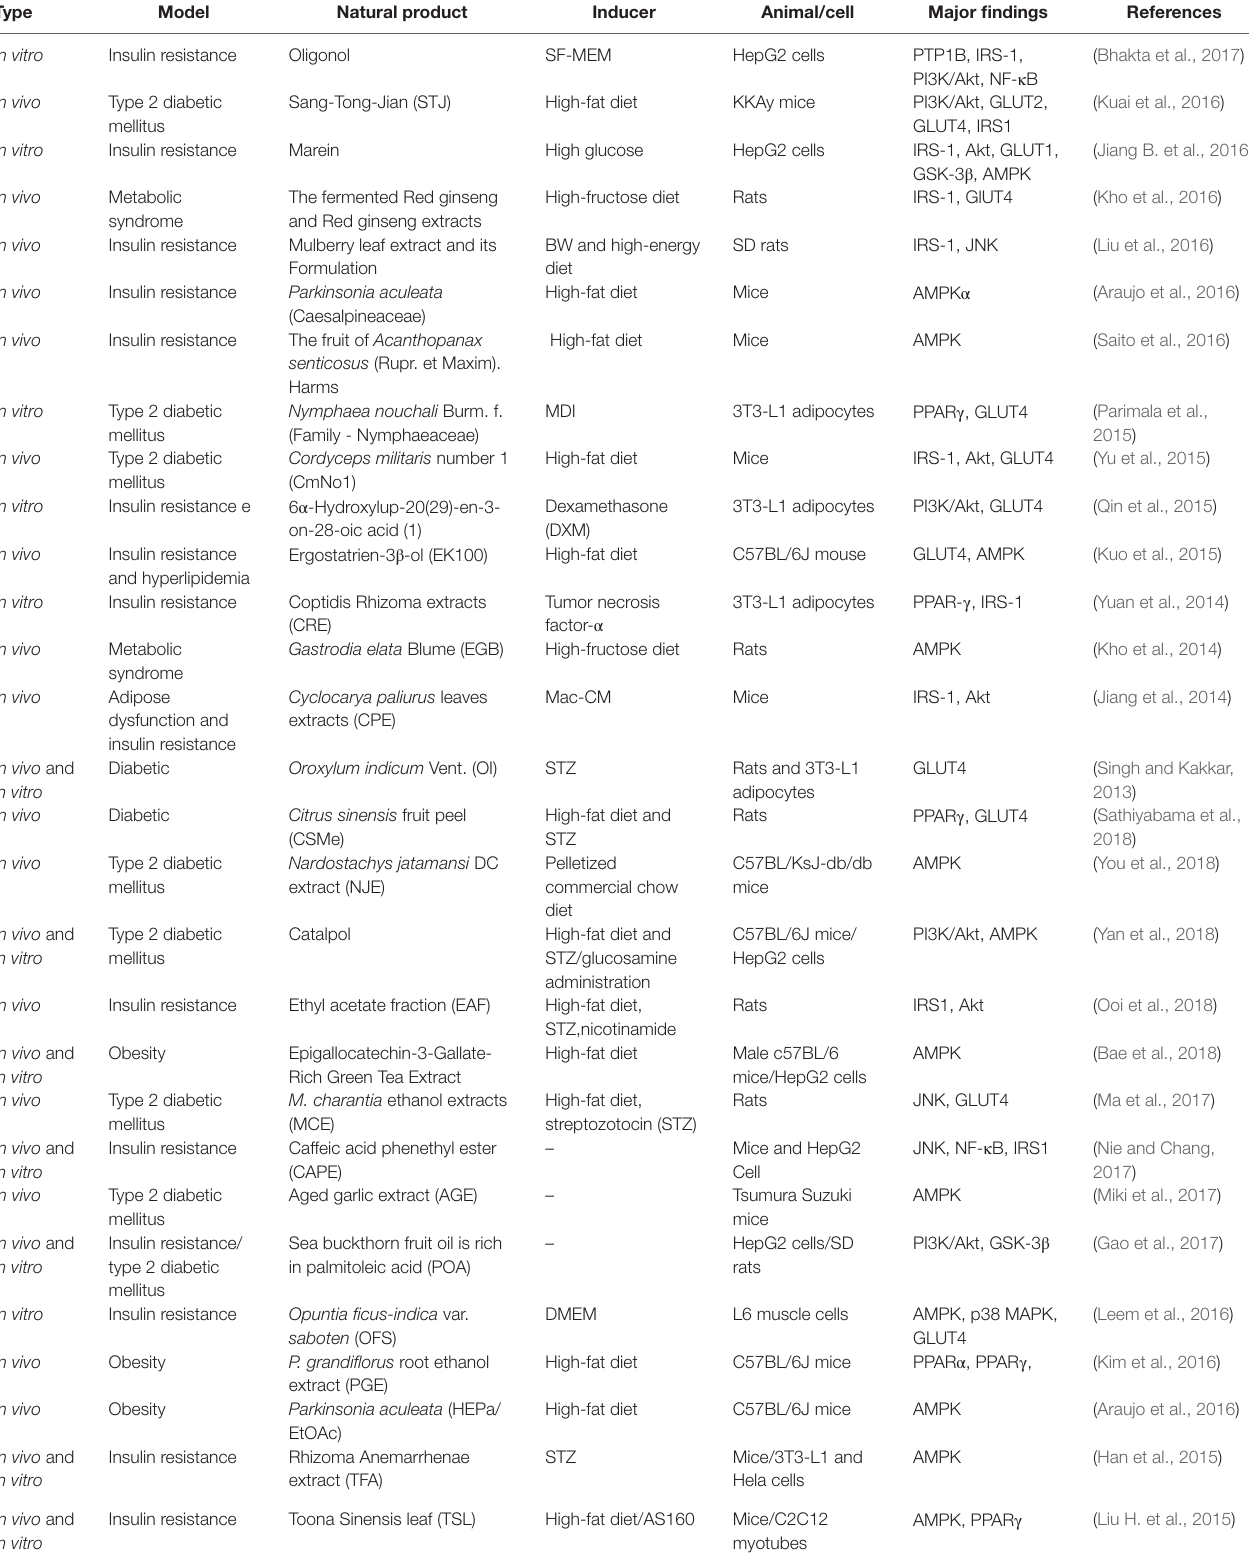
TABLE 5 | Natural product that improves insulin